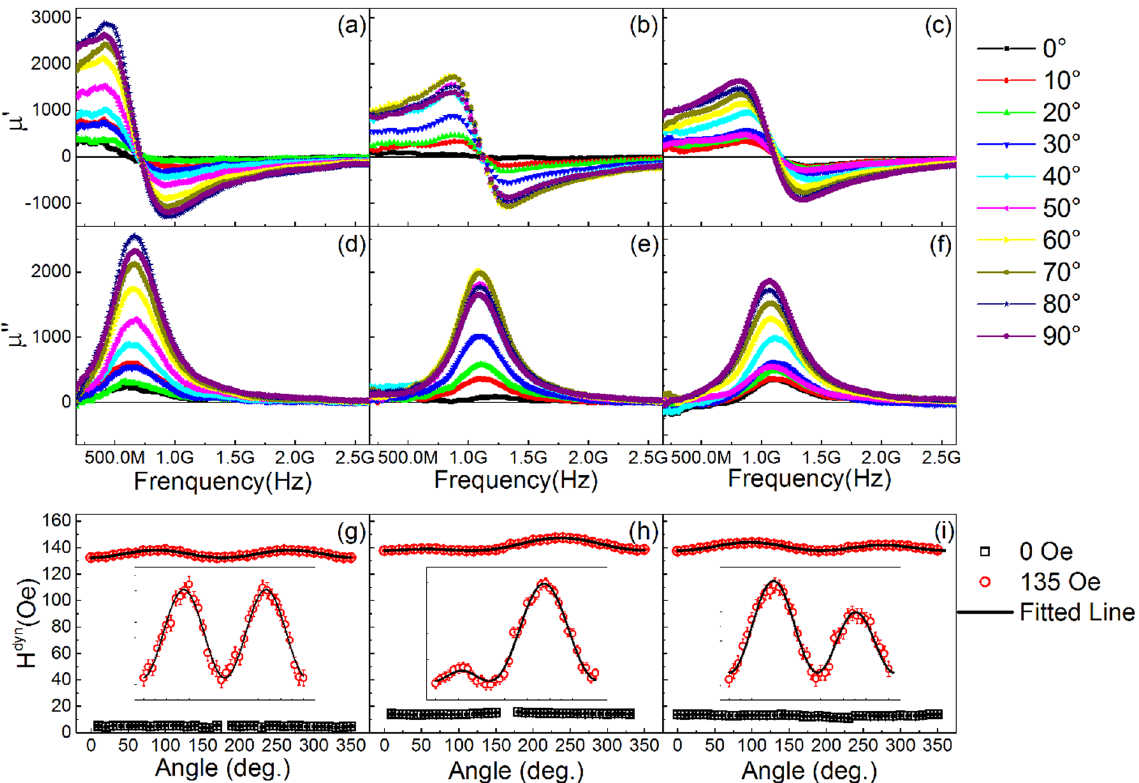
Figure 2. Dynamic properties of the FeNi single layer and AFM/FM bilayers. ( a – c ) zero-field real permeability of single FM layer, biased and unbiased AFM/FM bilayers, respectively, measured at angles from 0° to 90°. ( d – f ) are the zero-field imaginary permeability of corresponding films. ( g – i ) Dynamic anisotropy field H dyn fitted from the in-plane angle dependent frequencies of the FM layer, biased and unbiased AFM/FM bilayers, respectively, the black open squares are acquired from angle dependent resonance frequencies, the red circles are acquired from the resonance frequencies with a stationary magnetic field H 0 = 135 Oe applied along the direction of the microwave, the black lines are fitted curves to the frequencies, and the magnifications are presented in terms of insert to show in